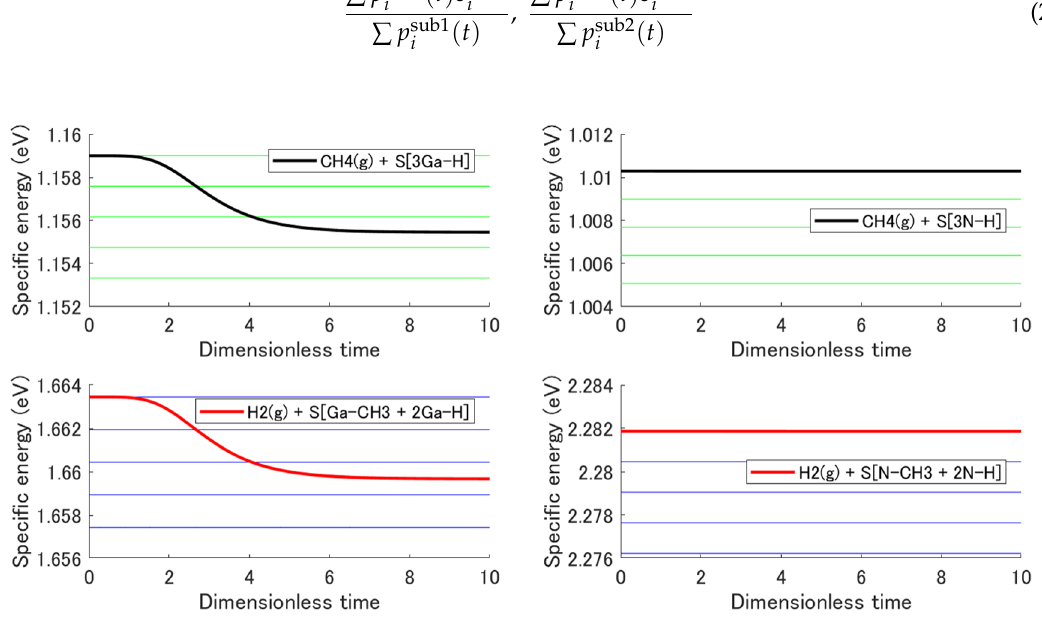
Figure 5. Evolution of the total probability of each subsystem for the adsorption reaction in (0001) and (000−1); that of subsystem 2 corresponds to the adsorption probability of CH 4 .